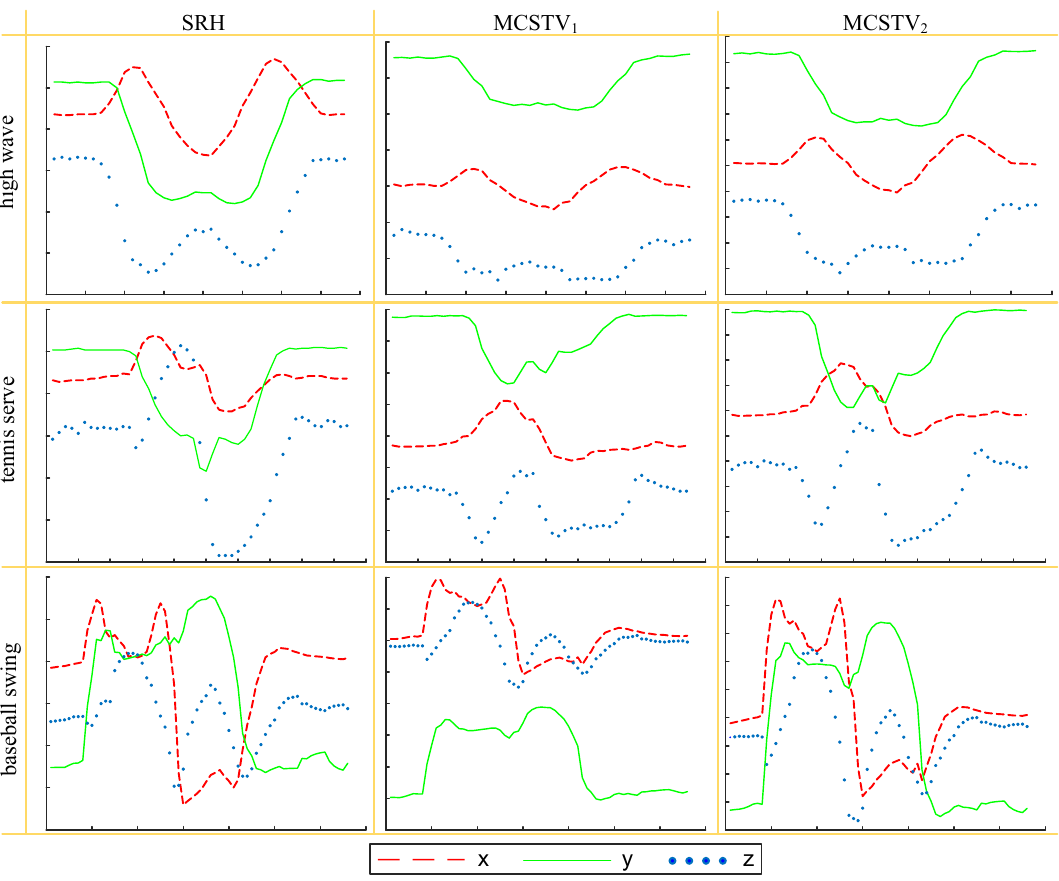
Figure 13. Various movement features of each